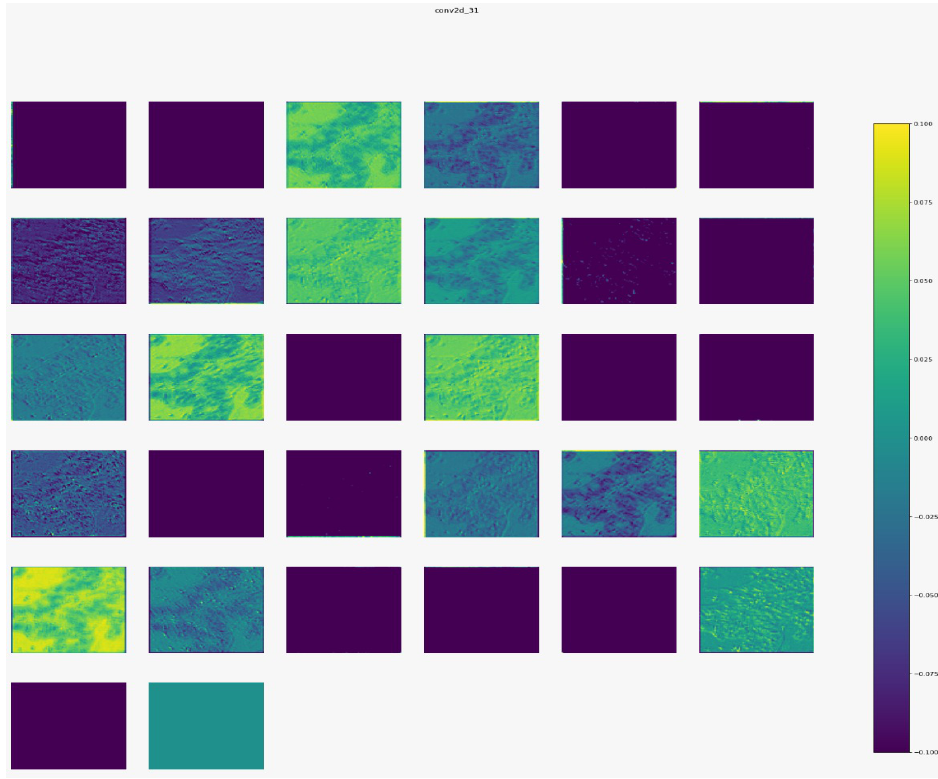
Figure 7. The output of the first Convolutional layer.